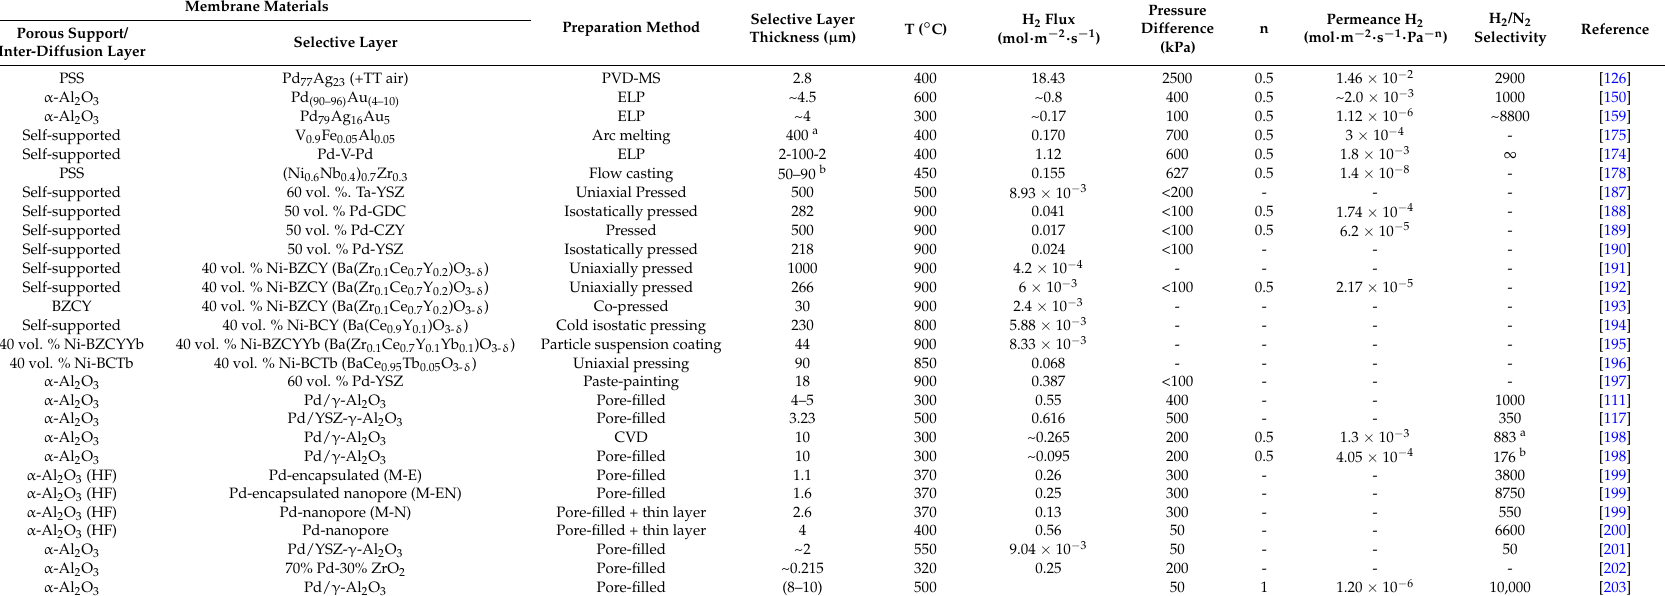
Table 10. Permeation data of some conventional supported membranes, cermet membranes and pore-filled membranes. Membrane